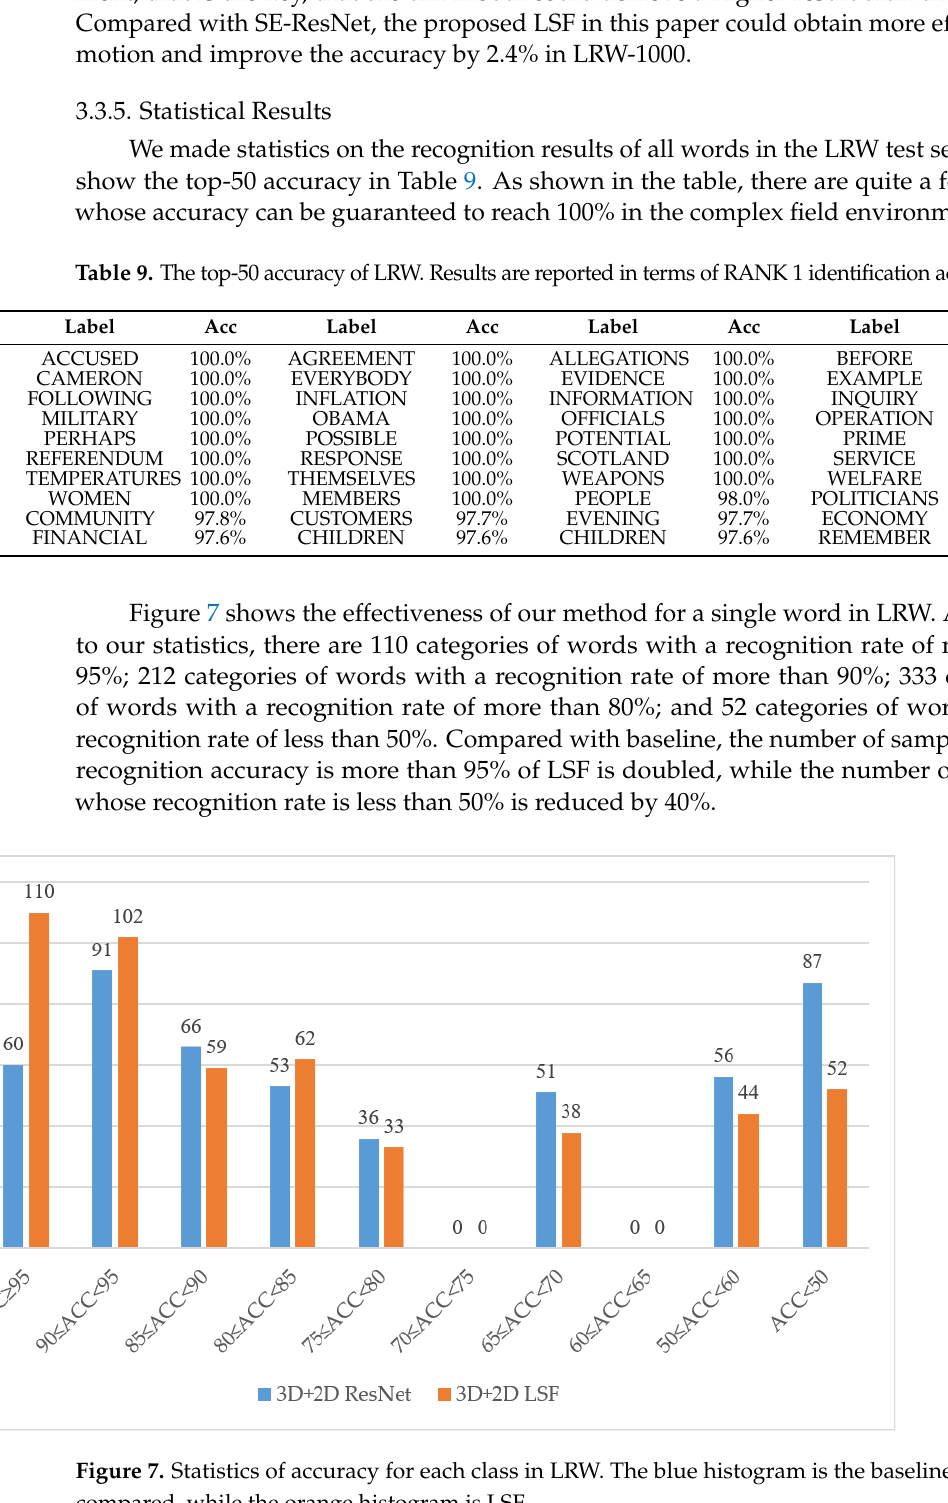
Figure 8. Statistics of accuracy for each class in LRW-1000. The blue histogram is the baseline model we compared, while the orange histogram is LSF. 4. Conclusions In this paper, we focused on enhancing the ability to extract spatial-temporal features in the front-end network of lipreading. A new front-end model with two effective CNN streams is proposed to extract relative dynamic features in the image sequence. We used a larger sampling interval and a CNN stream with a lower channel capacity to capture the